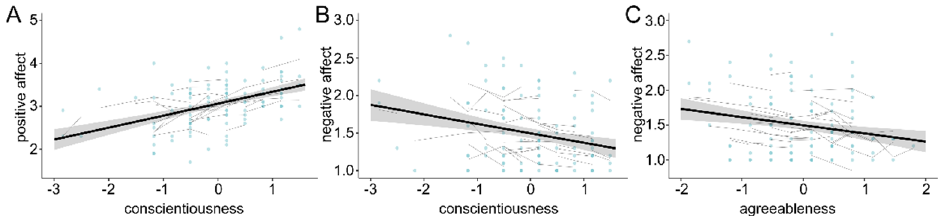
Figure 2. Relation between traits and positive and negative affect. Panel ( A ) depicts the relation between conscientiousness and positive affect, Panel ( B ) shows the relation between conscientiousness and negative affect, and Panel ( C ) indicates the relation between agreeableness and negative affect. Shaded error bars mark standard errors; small lines show random